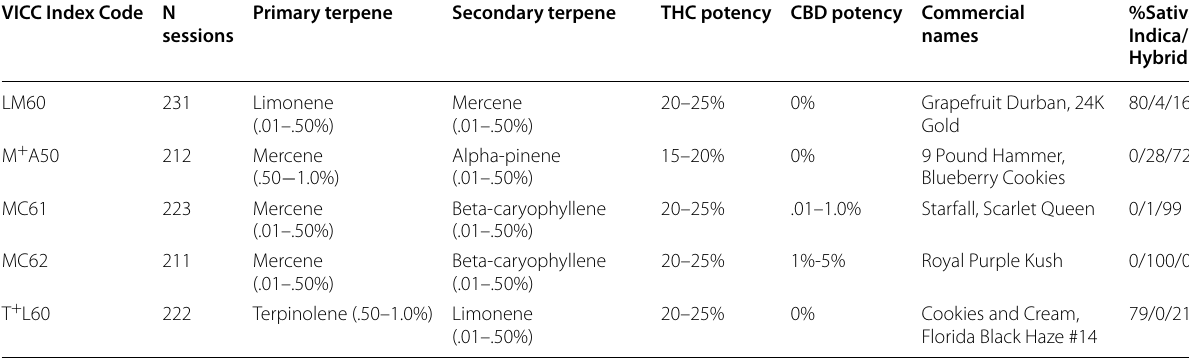
The VICC (Vigil Index of Cannabis Chemovars) uses a 4-unit coding system to indicate relative primary terpene and cannabinoid concentrations. Concentrations represent approximations with the tenths place rounded up to the next whole digit. Valid percentages of sativa/indica/hybrid label descriptions are